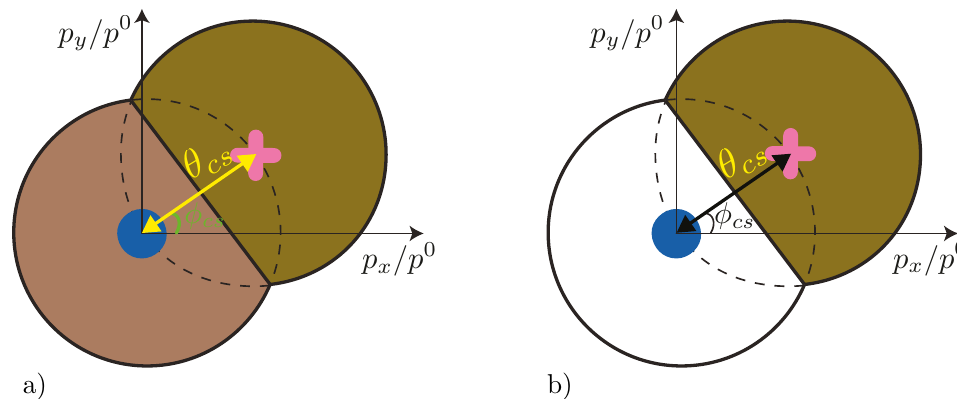
Figure 7 . The catchment area of nonperturbative modes relevant for a) the shift term and b) the boundary term up to LL, pictured from above looking down the jet axis (taken along the z - direction). These modes are clustered with either the collinear subjet located on the jet axis (blue dot), or the stopping collinear-soft subjet (pink cross) as indicated by the shaded brown regions. The overlapping circles both have radius (cid:18) cs